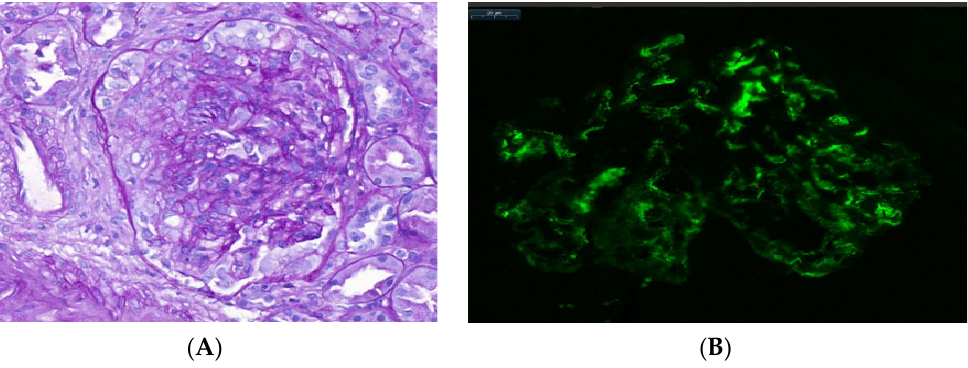
Figure 1. ( A ) Optical microscopy image, stained with PAS (Periodic Acid–Schiff). Increased endothelial–mesangial cellularity and extracapillary proliferation are observed in a patient with IgA nephropathy with crescents (original magnification ×20). ( B ) Immunofluorescence microscopy image shows intense (2+) mesangial IgA staining with granular pattern (bars: 20 μ m).